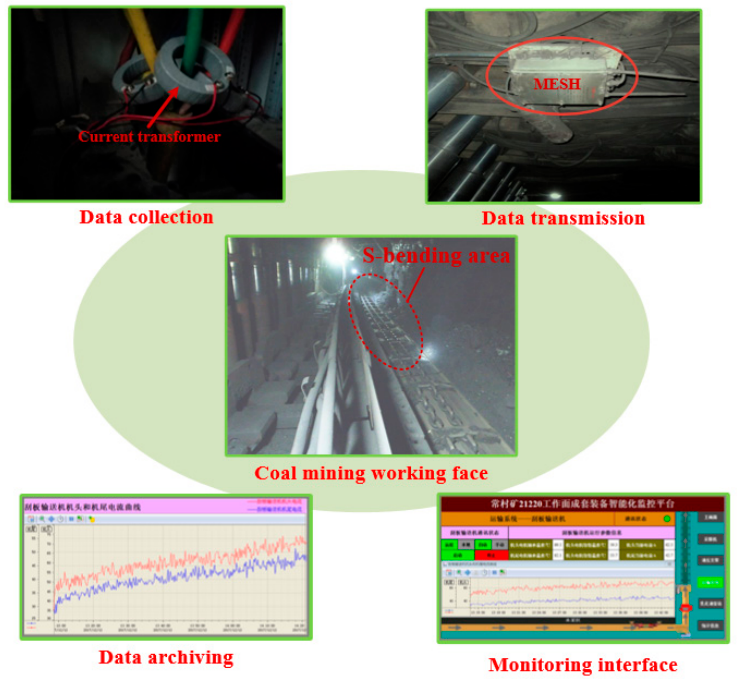
Figure 7. Industrial application of the proposed method.